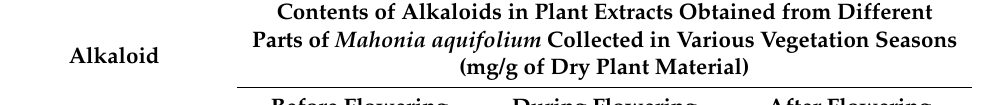
Table 2. Contents of isoquinoline alkaloids in plant extracts.